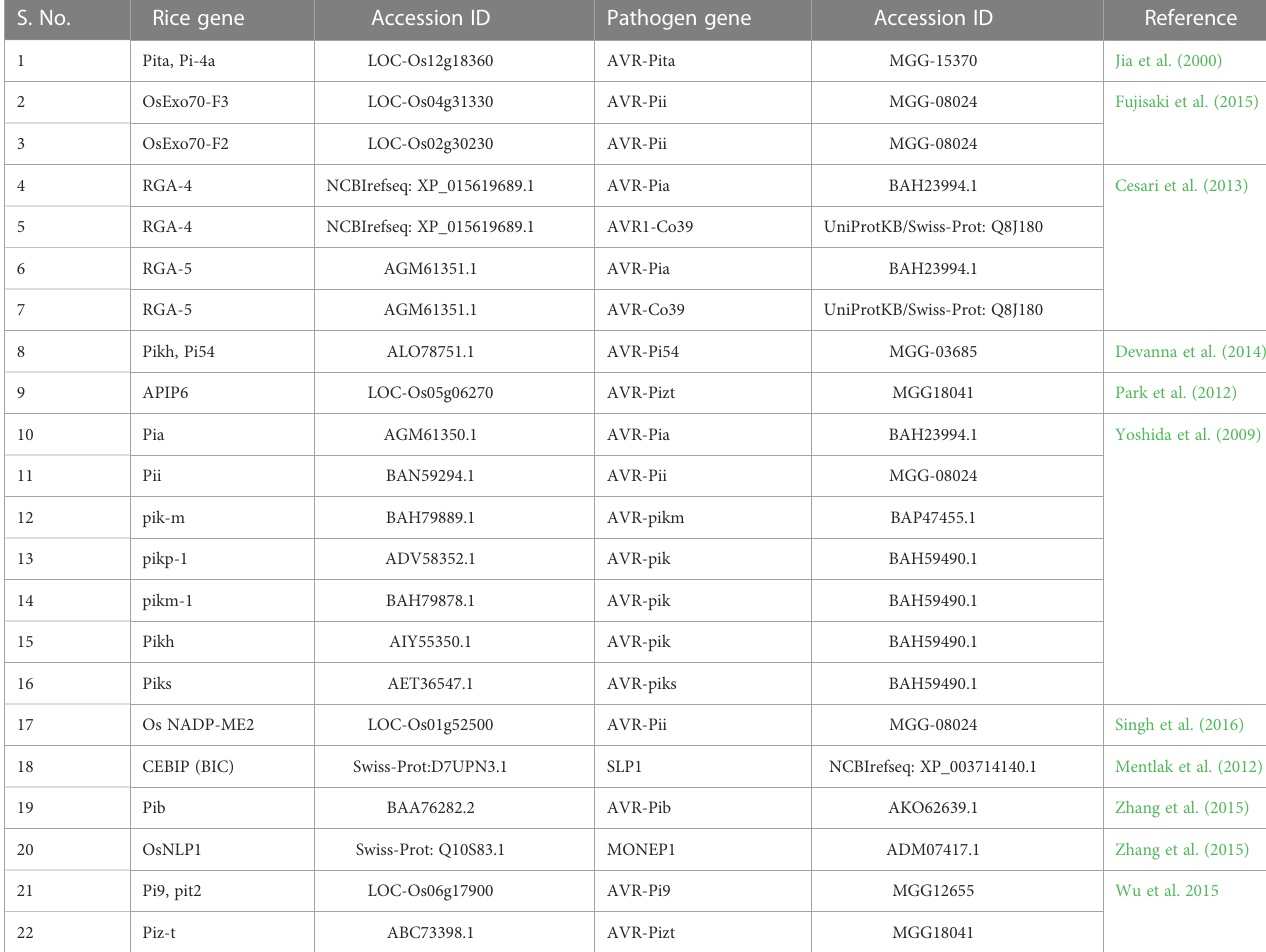
TABLE 1 List of experimental validated PPIs retrieved from literature search. S.